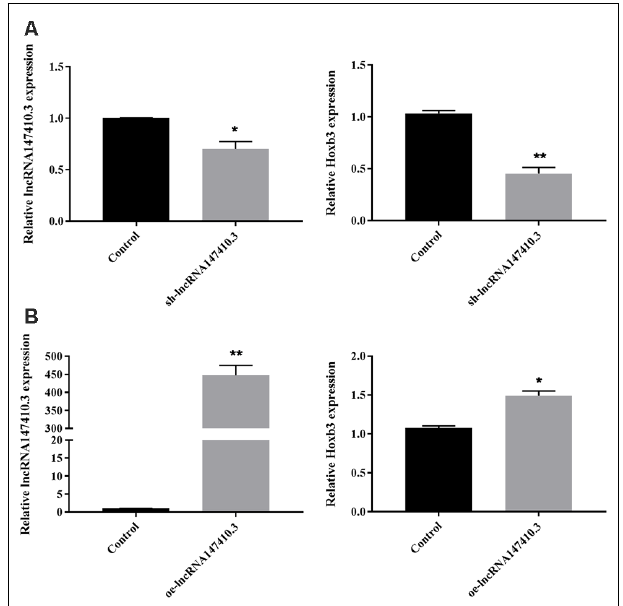
FIGURE 2 | The regulation of lncRNA147410.3 on target gene Hoxb3 was verified in cell level. (A) The expression of lncRNA147410.3 and Hoxb3 in BV-2 cells transfected with sh-lncRNA147410.3 or oe-lncRNA147410.3 was tested by qRT-PCR. All values are presented as mean ± SD for three independent experiments. * p < 0.05, ** p < 0.01, Student’s t -test. (B) The expression of lncRNA147410.3 and Hoxb3 in BV-2 cells transfected with oe-lncRNA147410.3 was tested by qRT-PCR. All values are presented as mean ± SD for three independent experiments. * p < 0.05, ** p < 0.01, Student’s t